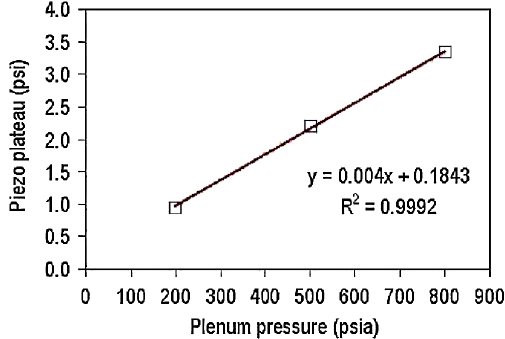
FIG. 19. Linearity of valve opening shown by local (static) pressure vs plenum pressure measured using